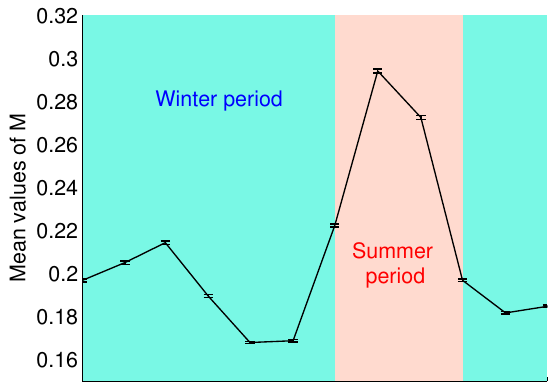
Fig. 8. Average annual cycle in the M values. The average is per- formed considering the central Arctic Basin buoy dataset. The error bars show the deviation 1 M from the average M value estimated using the central limit theorem and computed as 1 M = M √ where N M is the number of M values used to calculate the monthly mean M . Here, N M ranges from a minimum of 6 . 4 × 10 4 in Febru- ary to a maximum of 1 . 1 × 10 5 in